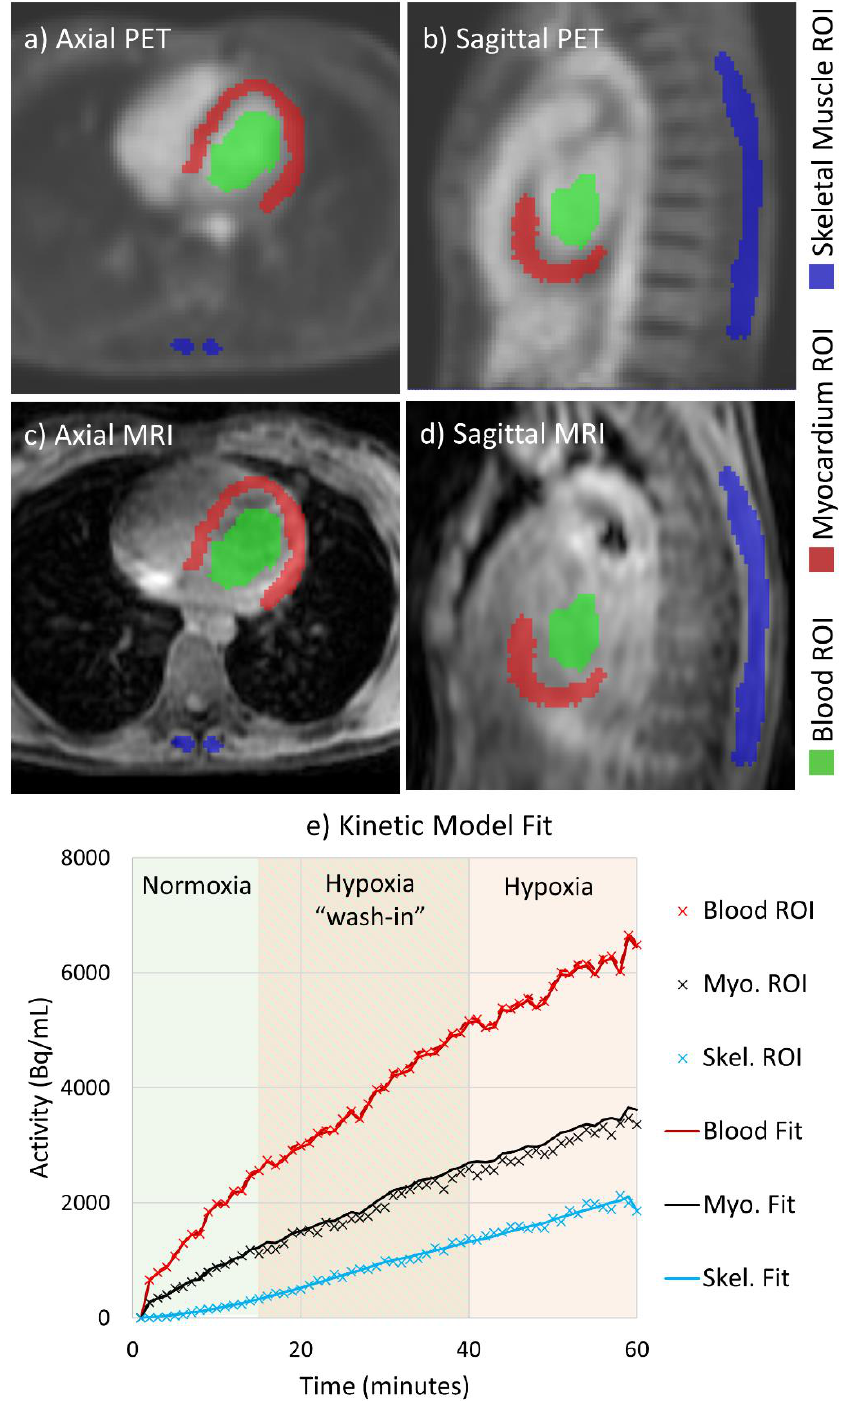
Figure 2. PET image processing method. Regions of interest (ROIs) were draw on the left ventricular (LV) myocardium, the LV cavity, and the paraspinal muscles using temporally averaged PET images ( a , b ) and co-registered MRI images ( c , d ). ( e ) the measured time-activity curves for each ROI (x’s on the graph) were used to fit 3-compartment models of FDG in the myocardium and skeletal muscle, in order to calculate the myocardial metabolic rate of glucose (MMRglc) and skeletal muscle metabolic rate of glucose (SkMRglc). The amount of F-18 fitted to each compartment over time is plotted as solid lines.